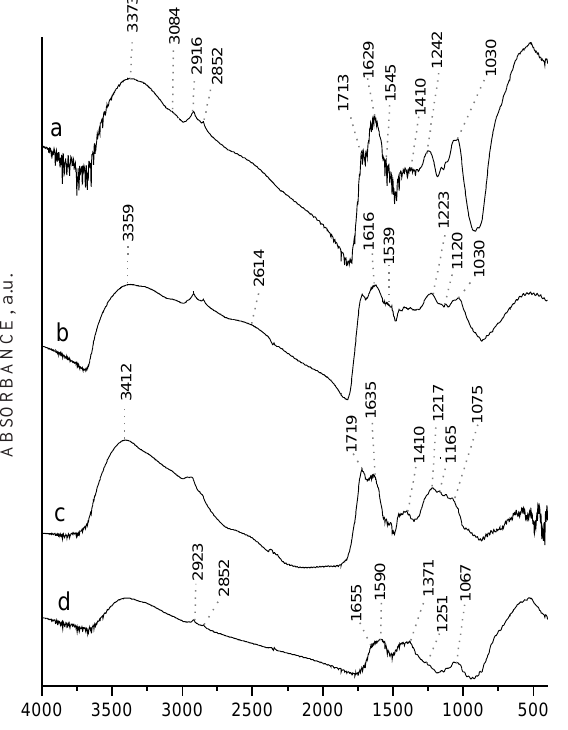
WAVENUMBER, cm -1 Figure 6. Transmission FTIR spectra of SOM (a) and its fractions: HA (b), FA (c) and HU (d) of the Latosol.